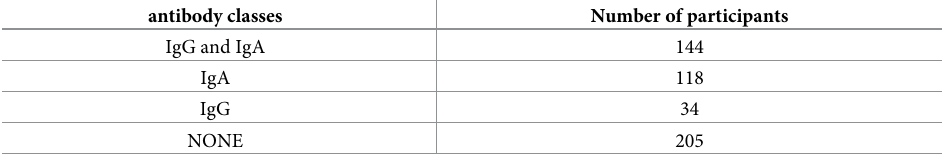
Table 1. Results of qualitative testing for SARS-CoV-2-specific antibodies in healthy individuals (N = 501), non- vaccinated and never diagnosed positively for SARS-CoV-2 infection.